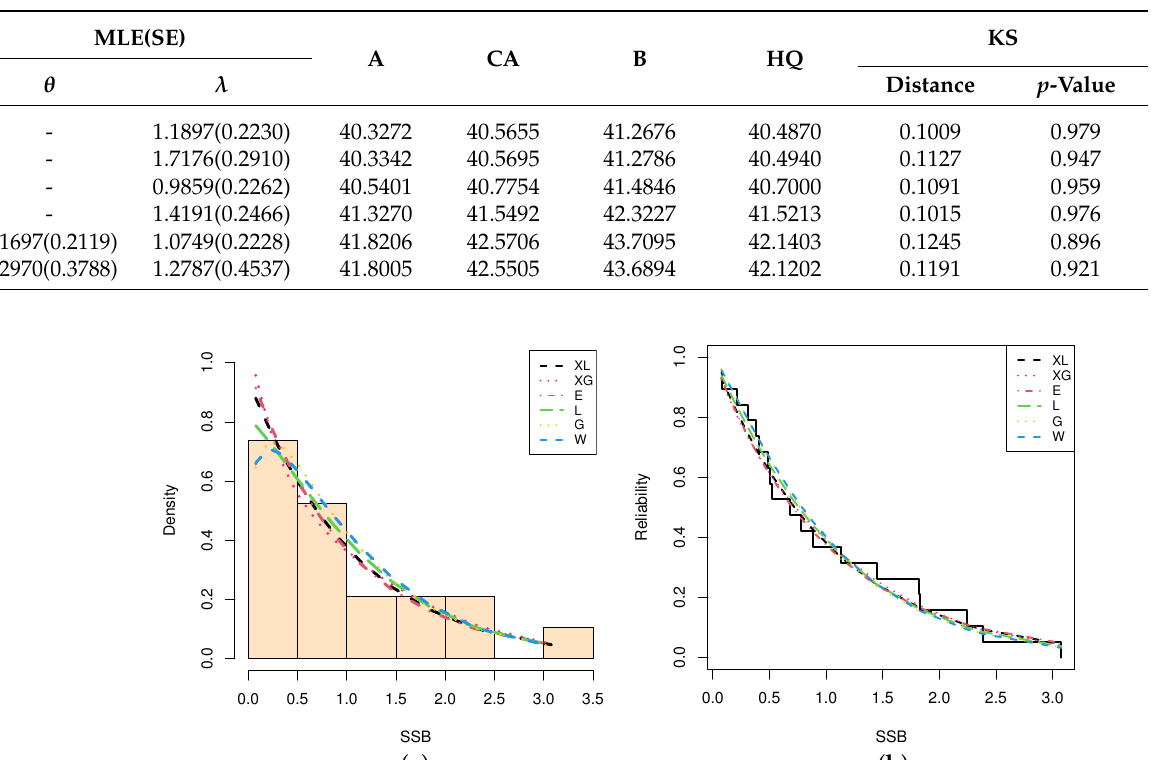
Table 1. Summary fit for the SSB data.